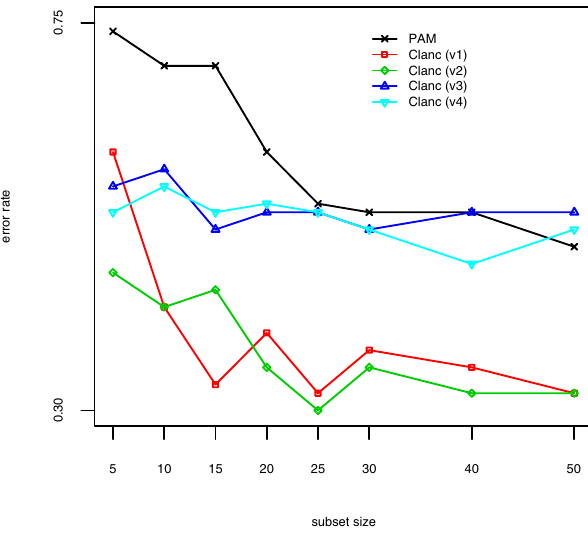
Figure 2. Results for Lymphoma data. Classifiers are identical to those in Tables 3 and 4, with Clanc v1-v4 corresponding to the last four variants reported there, respectively.